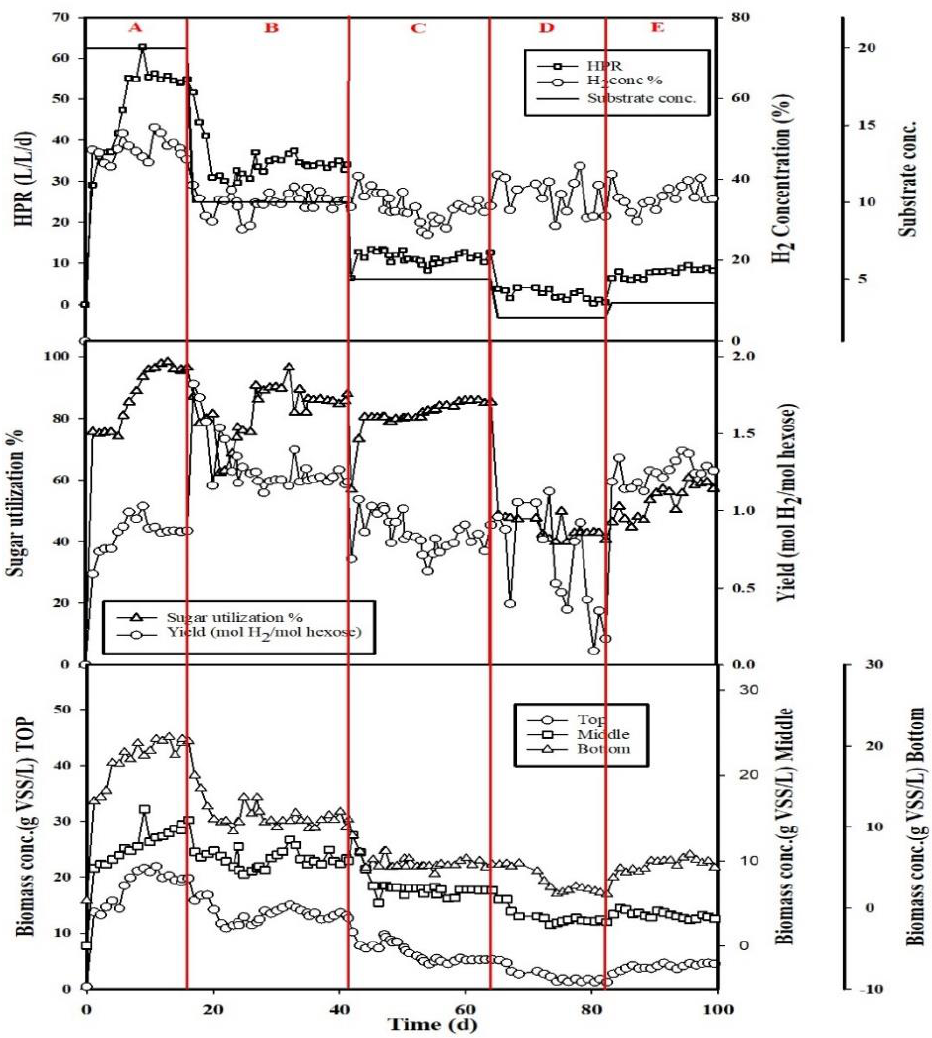
Figure 2. The performance of the hydrogen production evolution under different substrate concen- trations with HRT 1 h and h/H 0.5. Table 1. Hydrogen production performance at different substrate concentrations (HRT 1 h; h/H 0.5). Substrate Conc. (g Total Sugar/L)